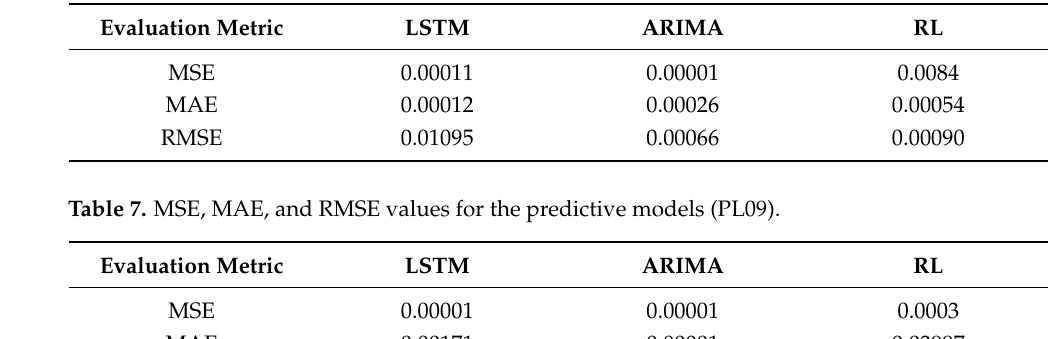
Table 6. MSE, MAE, and RMSE values for the predictive models (PL11).